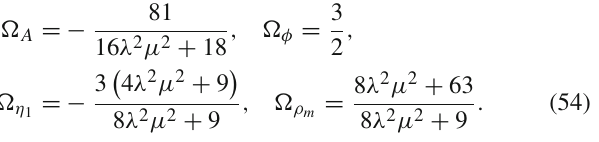
The eigenvalues of the F